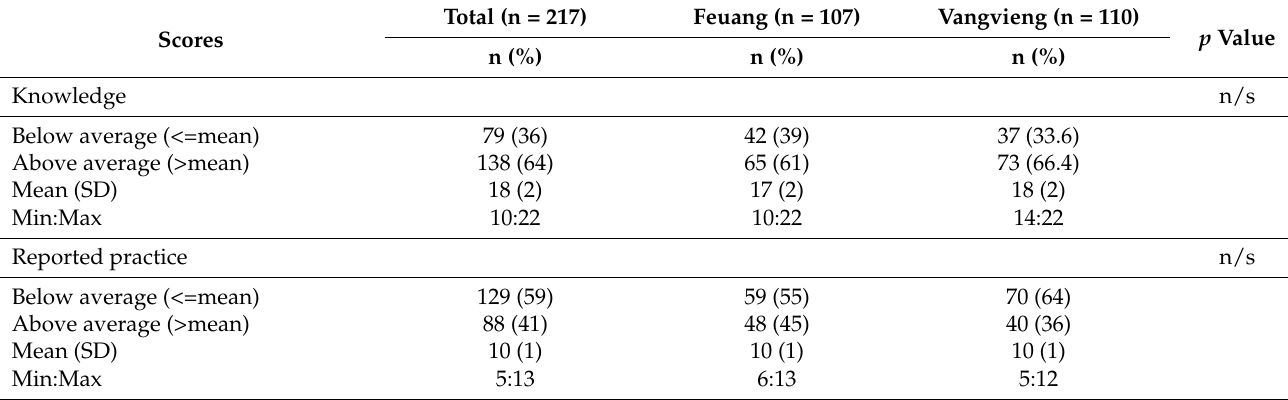
Table 5. Participants’ knowledge and reported practice scores regarding antibiotic use and resistance in both study districts.